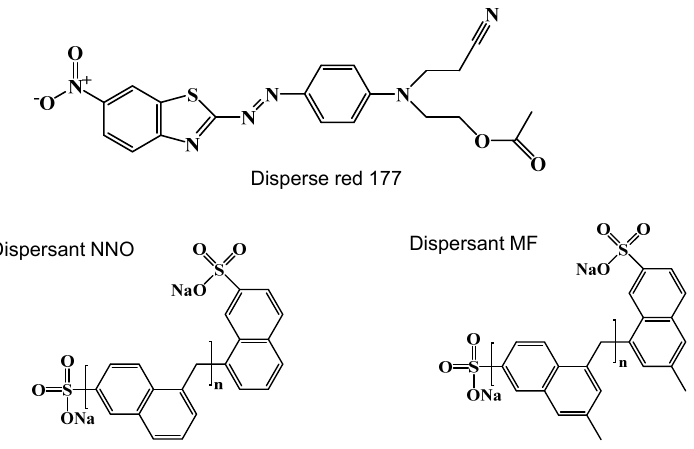
Figure 1. The molecular structure of disperse red 177, dispersant NNO, and MF.